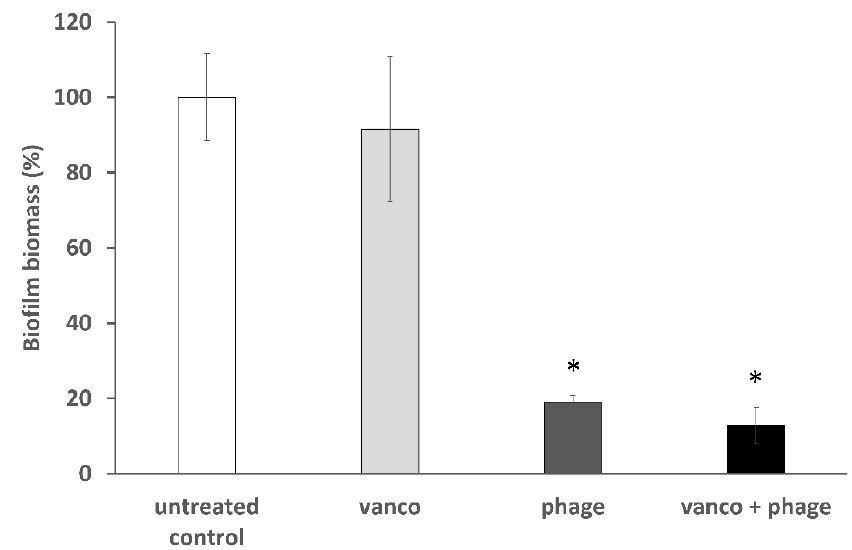
7 of 15 Figure 3. Viable counts of planktonic vancomycin-resistant E. faecalis following a combined treatment of phage EFLK1 and vancomycin. The colony forming units (CFU)/mL of VRE treated with 0.015 mg/mL vancomycin combined with phage EFLK1 1.2 × 10 8 PFU/well is presented. Bacteria were below the limit of detection after treating the cells by combining phage EFLK1 and vancomycin. Bacteria treated only with vancomycin showed survival scores like those of the untreated bacteria; cells treated with phage EFLK1 showed medium survival rates. Combining vancomycin and phage EFLK1 caused seven log reductions in CFU/mL. Light gray = vancomycin-treated bacteria, dark gray = phage EFLK1 treatment, black = phage EFLK1 + vancomycin. Statistically significant ( p < 0.01) compared to the untreated control. The results are mean ± SD based on three independent biological replicates. The infectivity of phage EFLK1, vancomycin and their combined treatment were assessed on several clinically isolated bacteria . Table 1 denotes the details of the tested bacteria, including their antibiotic resistance. Phage EFLK1 was found to be host-specific, infecting E. faecalis strains. In E. faecalis strains ( E. faecalis V583 , E. faecalis Aef01, E. faecalis Aef03, E. faecalis Aef05), adding phage EFLK1 with vancomycin showed better results than vancomycin alone, reducing the vancomycin MIC. 3.2. Combined Treatment of Vancomycin and Phage EFLK1 Reduced 72 h Biofilms Biofilms are one of the most challenging infection modalities to treat [38]. Thus, a combined treatment of phage EFLK1 and vancomycin against E. faecalis biofilm was investigated. After examining all the combinations of phage EFLK1 and vancomycin (Figure S3), we decided to focus on the mixture of the lowest concentrations that yielded the best synergistic effect both in planktonic bacteria and in biofilm: 0.015 mg/mL vancomycin and 1.2 × 10 8 PFU/well phage EFLK1. Consistent with the results for the planktonic cultures, combinations of phage EFLK1 and vancomycin increased killing in the vancomycin-resistant E. faecalis biofilm (Figures 4–6). Biofilm biomass was assessed by crystal violet staining (Figure 4). Following combined treatment of phage EFLK1 (1.2 × 10 8 PFU/well) and vancomycin (0.015 mg/mL), the biomass decreased by 87%. Biofilm treated with vancomycin alone showed high biomass levels with only an 8% decrease. Treatment of biofilm with phage EFLK1